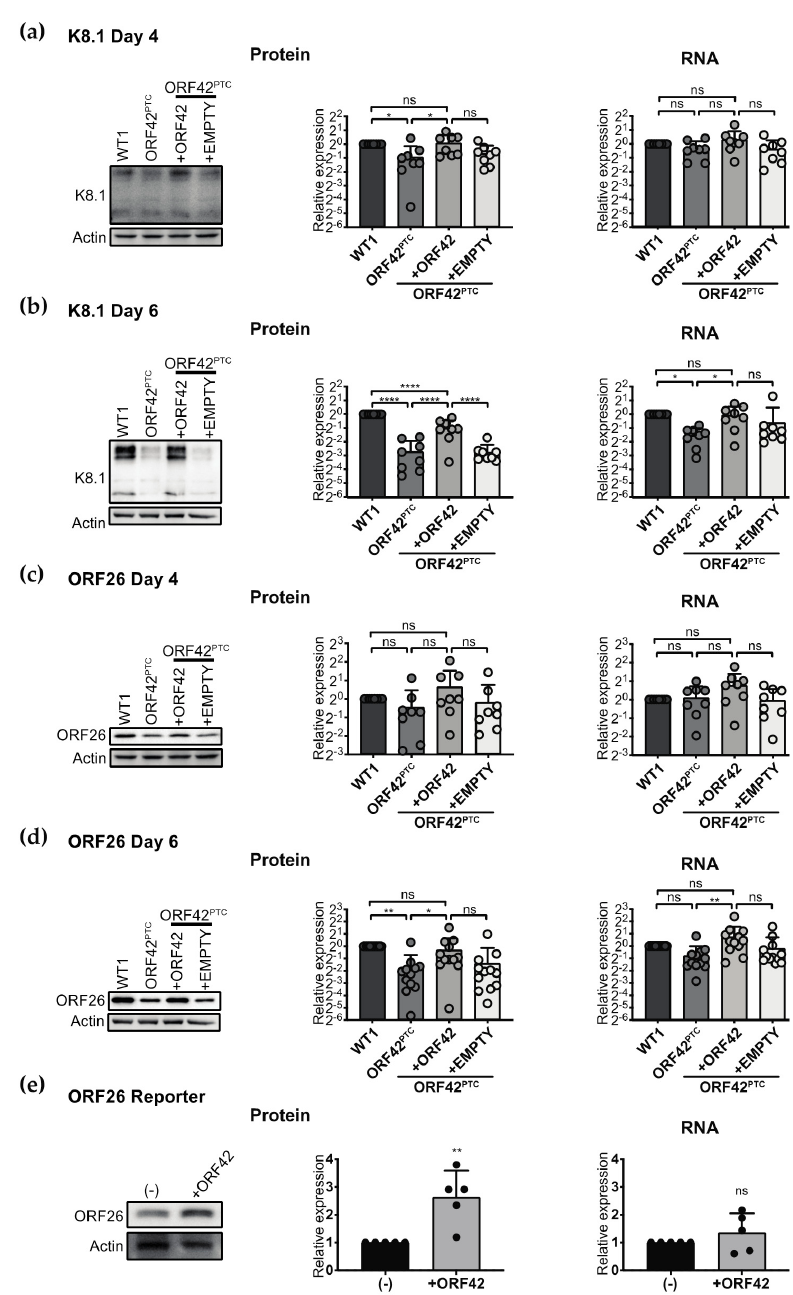
Figure 5. ORF42 may regulate gene expression post-transcriptionally. ( a – d ) The lytic cycle was induced in the KSHV-infected iSLK.RTA cells by addition of doxycycline (1 µ g / mL) to the media. Protein and mRNA were collected four ( a , c ) and six ( b,d ) days post-induction from the same biological replicate. The levels of K8.1 ( a , b ) and ORF26 ( c , d ) proteins and mRNAs are reported relative to WT1. n ≥ 8. ns, *,**,**** = p > 0.05, < 0.05, < 0.01, < 0.0001 (ANOVA followed by Sidak’s corrected multiple comparison test). ( e ) A construct expressing the ORF26 coding region and UTRs was co-transfected with either ORF42 (untagged) or empty vector. Protein and RNA were collected 24 h later. n = 5; ns, ** = p > 0.05 or < 0.01, respectively (Student’s t -test). In all panels, levels of viral mRNAs and of cellular 18S rRNA were measured by RT-qPCR. Viral mRNA levels were then normalized to 18S rRNA levels and are shown relative to WT1 ( a – d ) or vector transfected cells ( e ). Protein levels were measured by Western blotting and normalized to actin, and are also shown relative to WT1 ( a – d ) or vector transfected cells ( e ). Representative Western blots are included. Bar graphs represent mean values ± standard deviation and individual measurements are